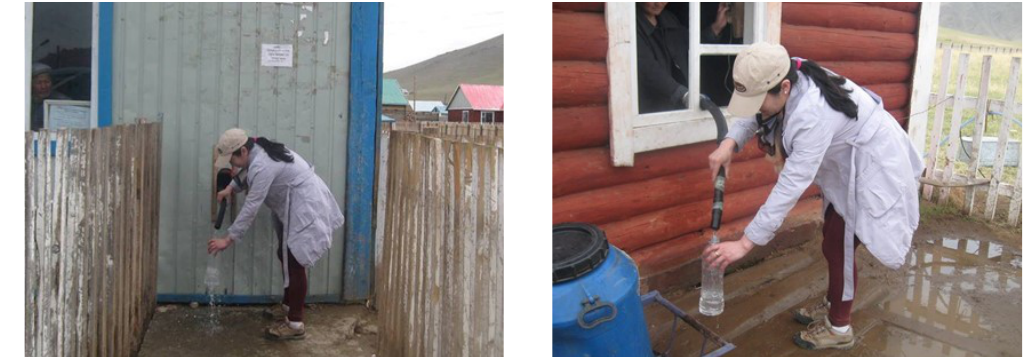
Figure 4. Groundwater sampling in school (right) and center of Jargalant soum (left) eqv/dm 3 , pH of 7.97, oxidation of 2.1 mg/dm 3